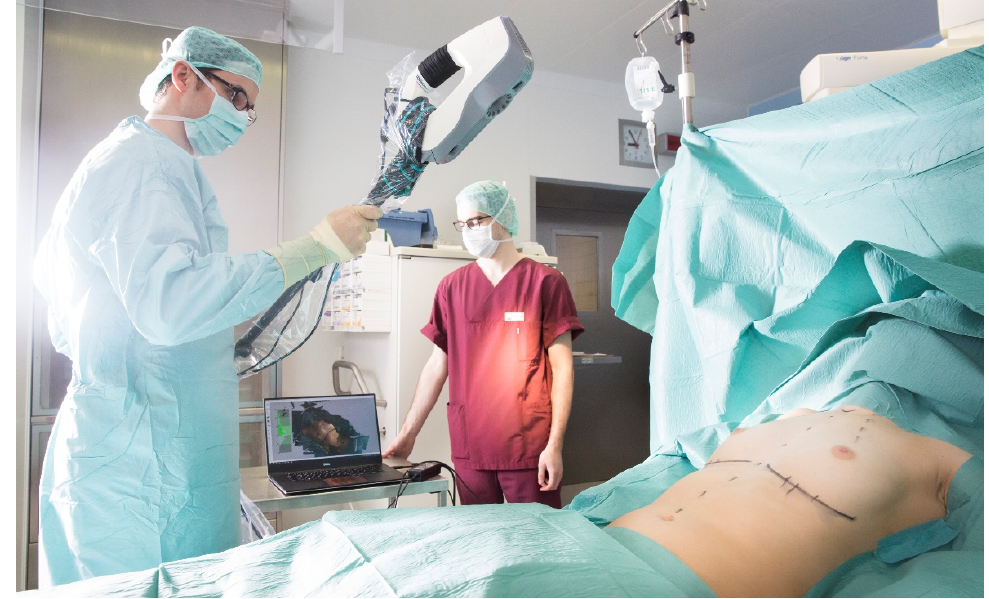
Figure 1. The intraoperative scan with 3DSI for a patient who underwent submuscular breast aug- mentation.